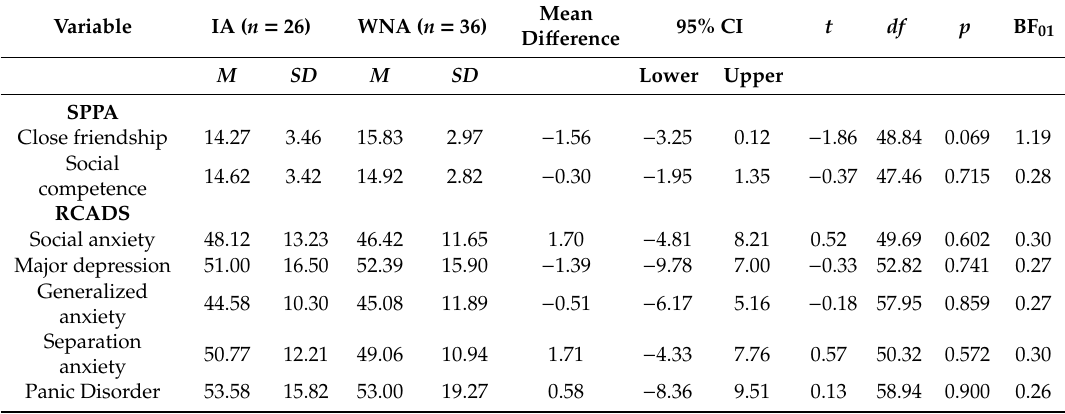
Table 1. Summary of study variable of means, standard deviations and mean di ff erence, 95%CI, t -value, p value, e ff ect